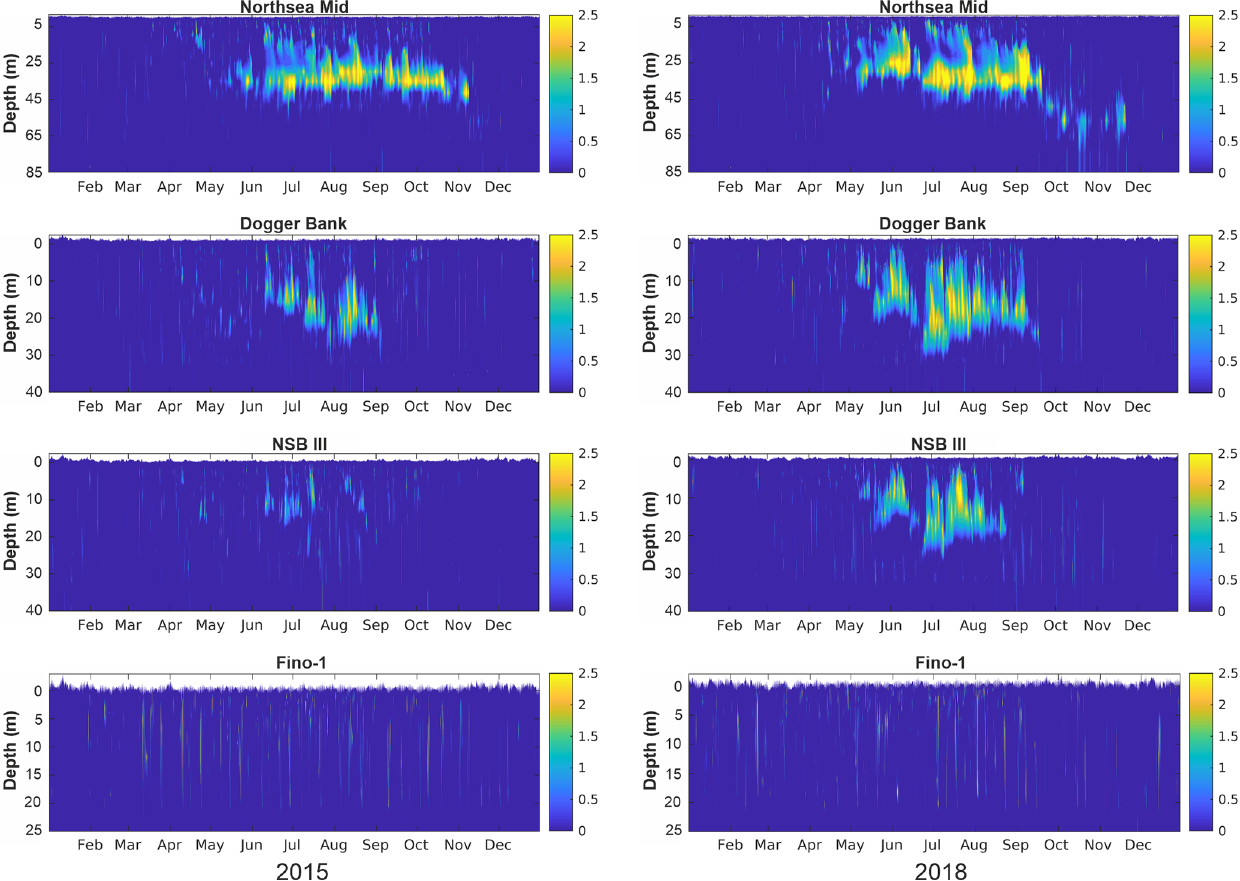
Figure 11. Gradient Richardson numbers Ri for 2015 (left column) and 2018 (right column) at the Northsea Mid, Dogger Bank, NSB III and Fino-1 on a log 10